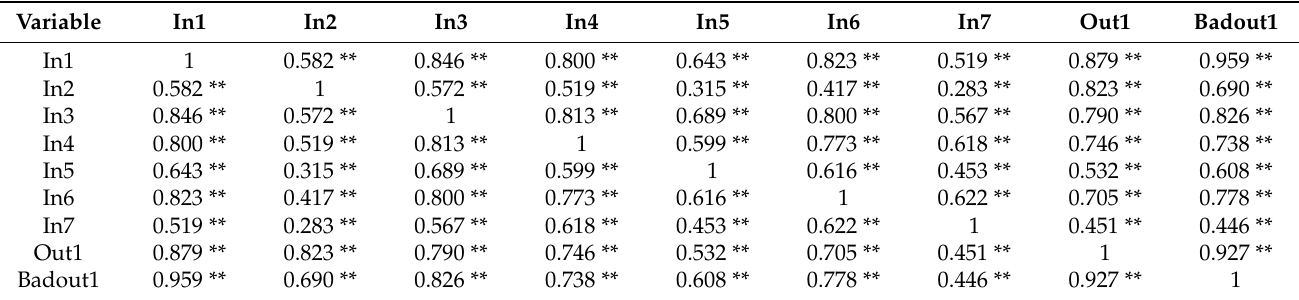
Table 2. Pearson correlation test for input and output